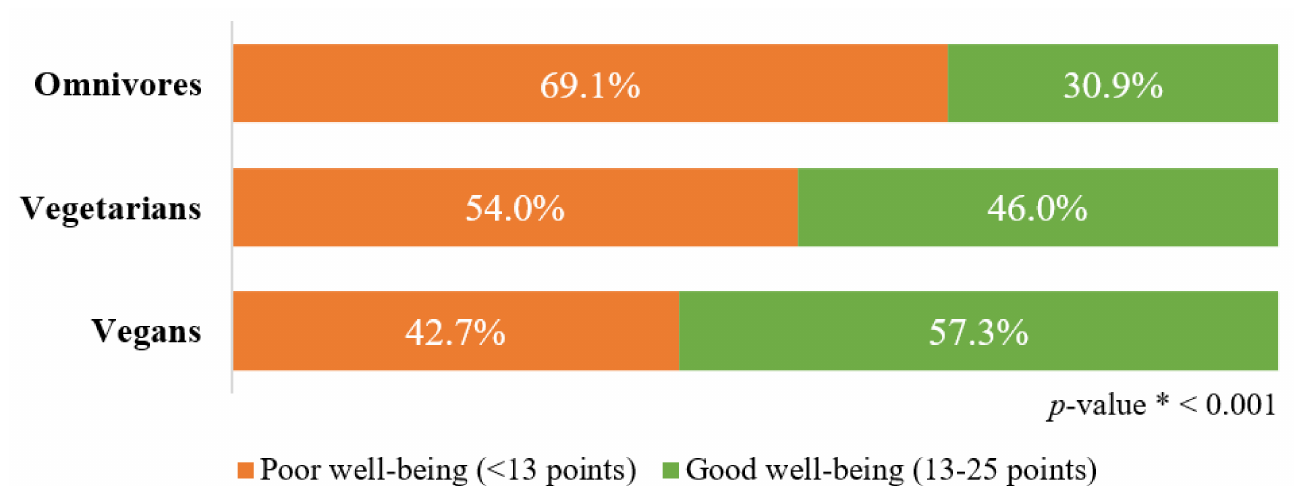
Figure 2. Percentage distribution of omnivores, vegetarians, and vegans by well-being status. Well- being was assessed using the WHO-5 Well-Being Index (range 0–25 points), where < 13 points mean poor well-being and ≥ means good well-being; * p -value was determined using Chi-square